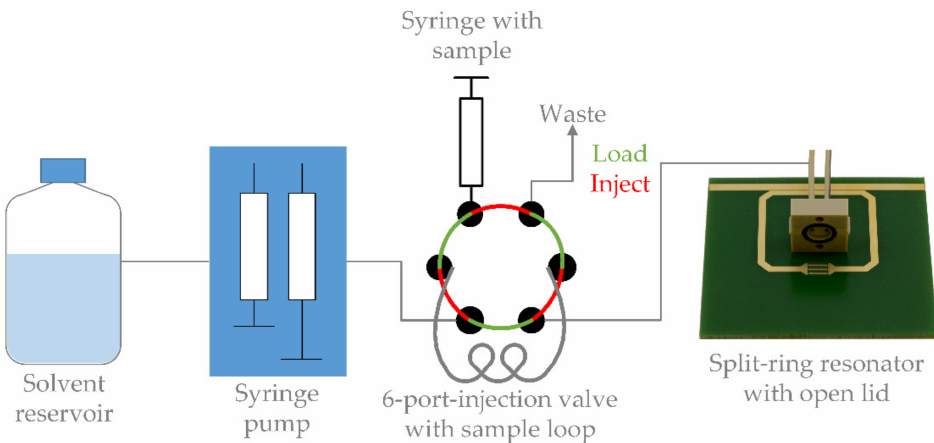
Figure 3. Measurement setup for continuous flow consisting of a solvent reservoir, two syringe pumps to achieve continuous flow, 6-port-valve with sample loop with a volume of 20 µ L for sample injection and the split-ring resonator with open lid (for better